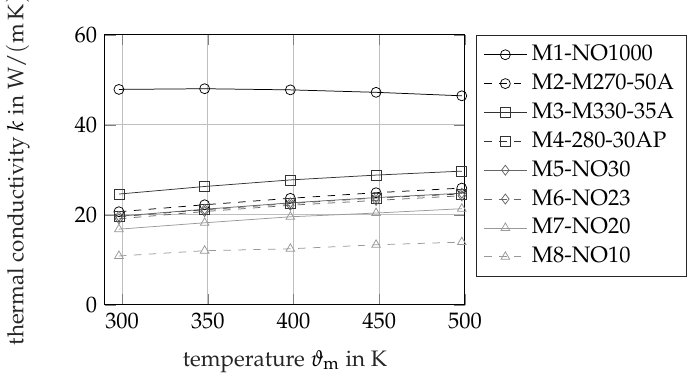
Figure 11. Results of the measurements of the thermal conductivity k m